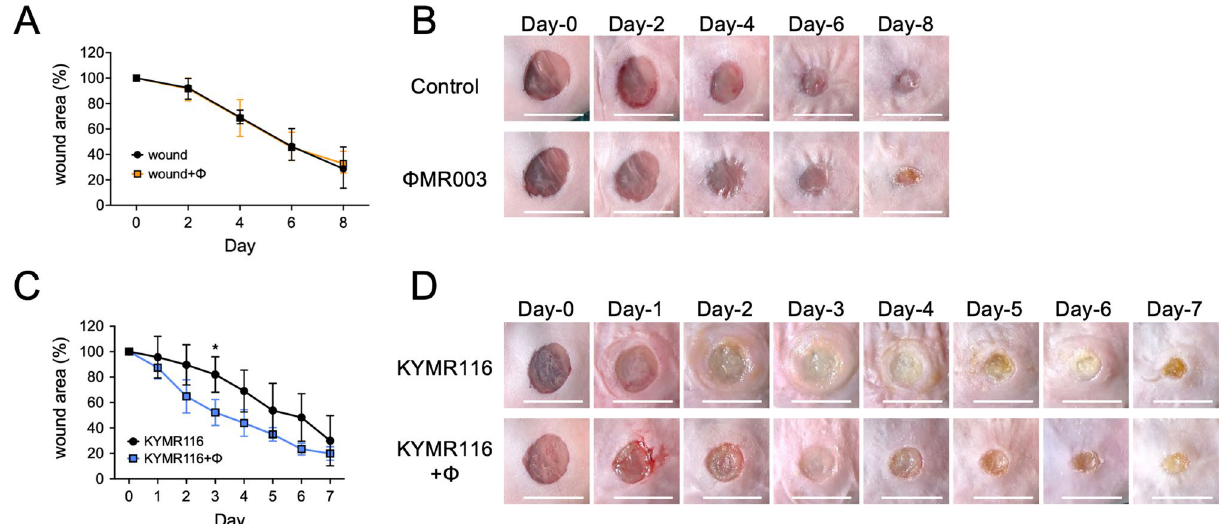
Figure 2. The wound closure rate of the 6.5 mm diameter skin excision. After the administration of buffer (wound) or phiMR003 (wound + ϕ), wound size was measured every other day ( A ). The effect of phiMR003 on wound closure was assayed in KYMR116-infected wounds after the administration of buffer (KYMR116) or phiMR003 (KYMR116 + ϕ) ( B ). Data indicate the mean rate of five mice in each group. Error bars indicate the standard errors of the means (SEMs). The Mann ‒ Whitney U test determined the significance of the data on the 3rd day (* P < 0.05). Two-way analysis of variance (ANOVA) was used to determine the level of statistically significant phiMR003 administration ( P < 0.05). Representative photographs of the wound are shown in ( B ) and ( D ). Scale bars, 10